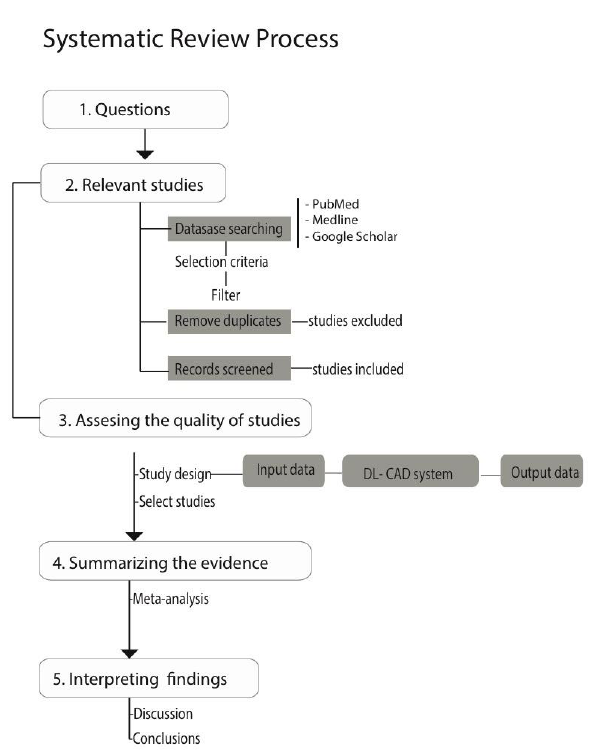
Figure 3. This flowchart diagram represents the review process of articles in this paper. DL-CAD: deep learning computer-aided